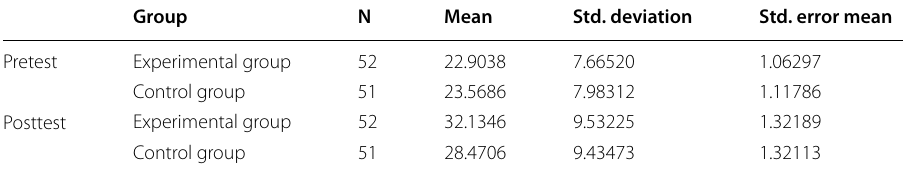
Table 3 Descriptive